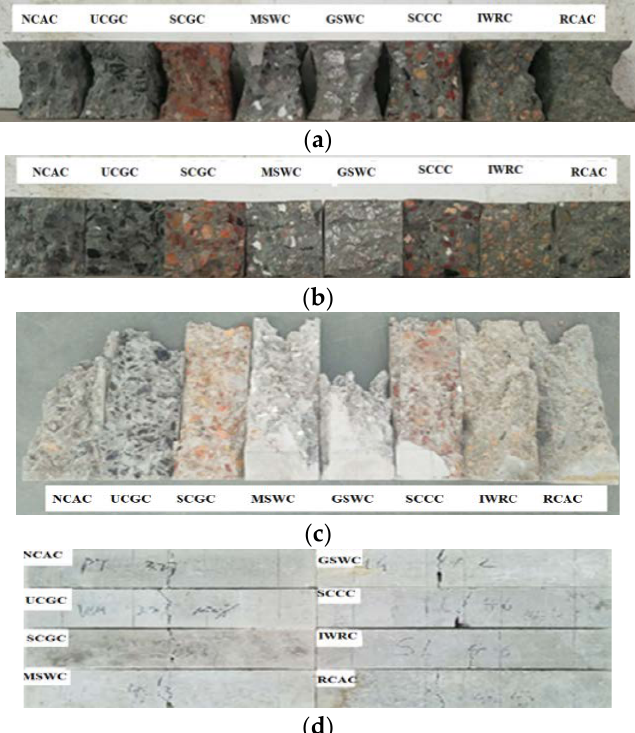
Figure 6. Failure characteristics of different kinds of coarse aggregate concrete: ( a ) cubic compression; ( b ) splitting tension; ( c ) axial compression; ( d ) bending.